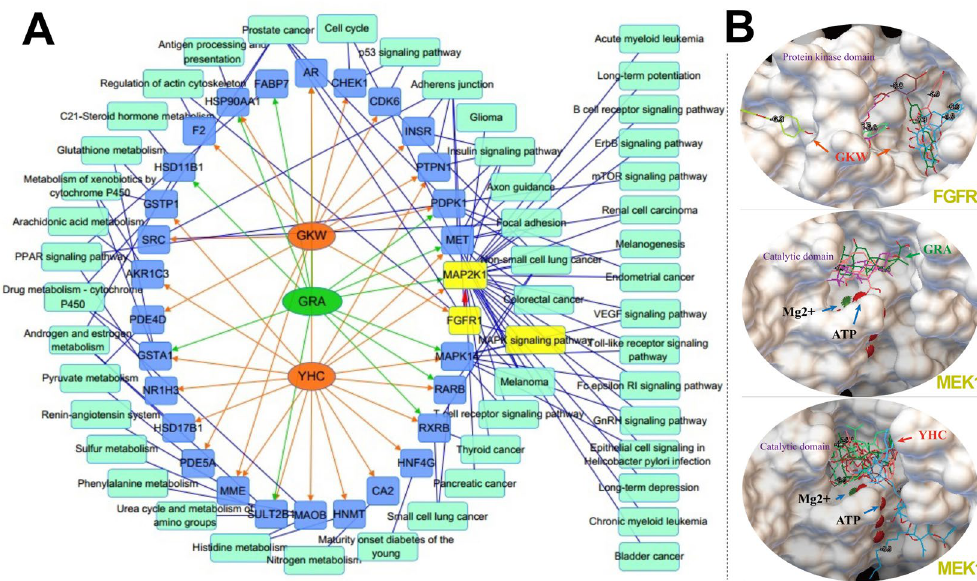
Figure 6. YHC, GKW and GRA may all target on ERK-MAPK pathway. ( A ) Network of targets and pathways (including diseases) interact with YHC, GKW or GRA. Network pharmacology study identified 30 potential targets and 49 potential pathways for these compounds. The targets and pathways linked with GRA were mostly linked with GKW or YHC, which indicate tight interactions between YH and GC. Among the shared targets and pathways, MAP2K1 (equal to MEK1) and FGFR1 are the upstream factors of ERK-MAPK pathway (yellow nodes). This pathway mediates renal AQP 2 expression. Nodes of targets are blue, nodes of pathways are light green, edges linking molecules and targets are orange (YHC and GKW) or green (GRA), edges linking targets and pathways are blue. ( B ) Molecule docking images showing how YHC, GKW and GRA bind to the active domain of their targets, in each case at least 3 to 8 confirmations of different binding mode composed the interactions between ligands and targets (confirmations of the same ligand were merged together). The docking study confirmed the ERK-MAPK pathway, which may be potentially influenced by YHC, GKW and GRA. The active domains were confirmed by GeneCards (http://www.genecards.org/), Mg2 + and adenosine triphosphate (ATP) were coenzymes of